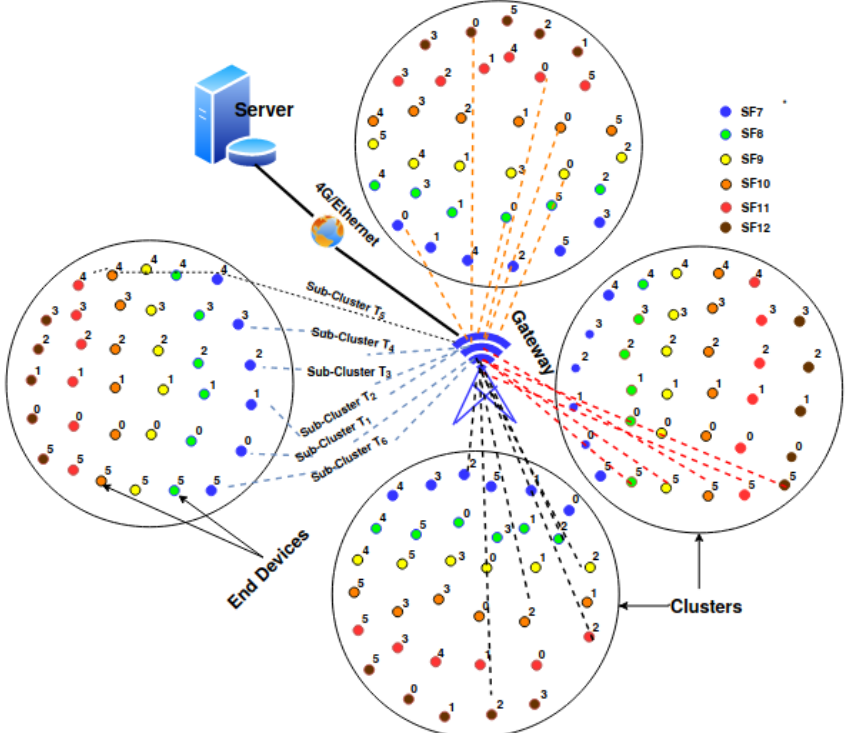
Figure 2. Example of OAPM architecture with 4 clusters in the monitoring